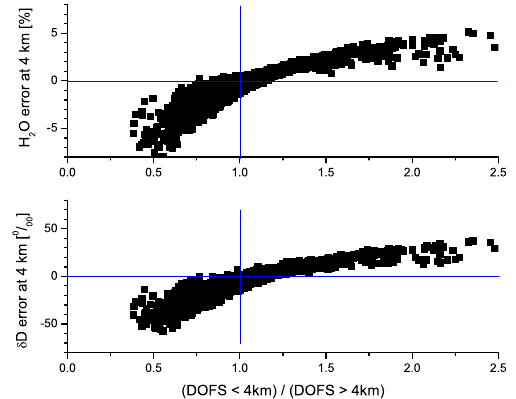
Fig. 7. Error response at 4km of a systematic spectroscopic line parameter uncertainty to the vertical sensitivity of the remote sensing system at Iza˜na (expressed by the ratio between the DOFS values for the lower and the middle/upper troposphere). Top panel: H 2 O; bottom panel: δ D.